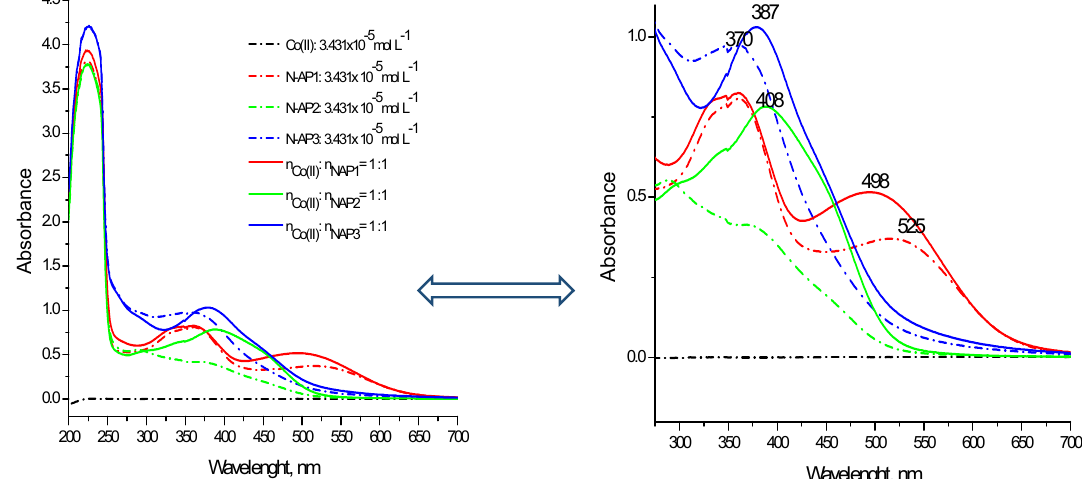
Figure 7. Absorption spectra of Co (II) -N-AMP(L) complexes in a ratio of 1:1 and of unbound azo compounds.